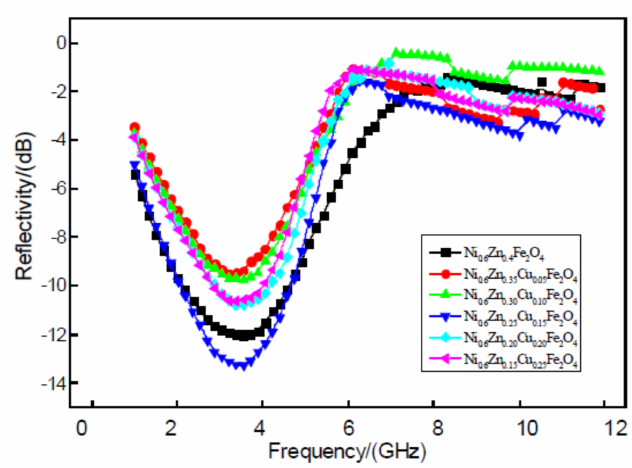
Figure 12. Curves of reflectivity and frequency for the Ni 0.6 Zn (0.4 − x) Cu x Fe 2 O 4